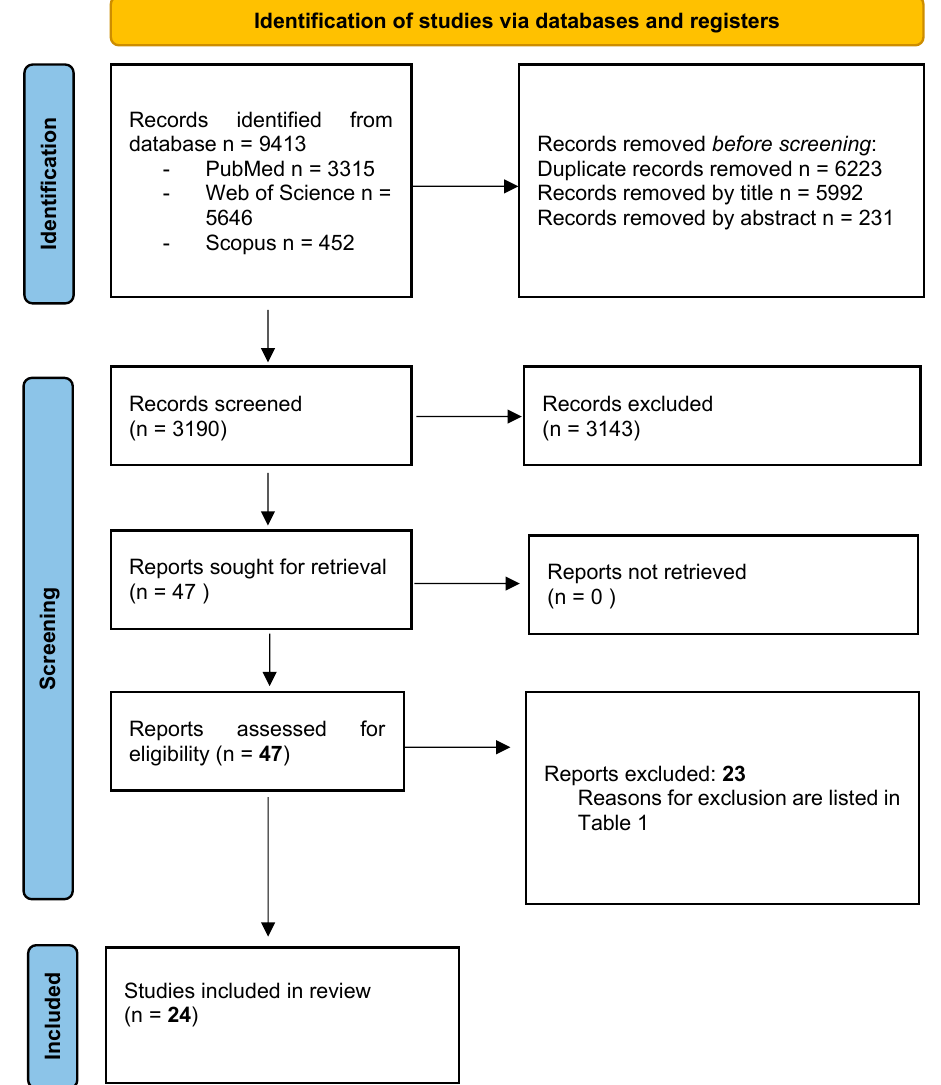
Figure 2. PRISMA 2020 Flow Diagram of the screening process. In total, 24 studies were included in the present systematic